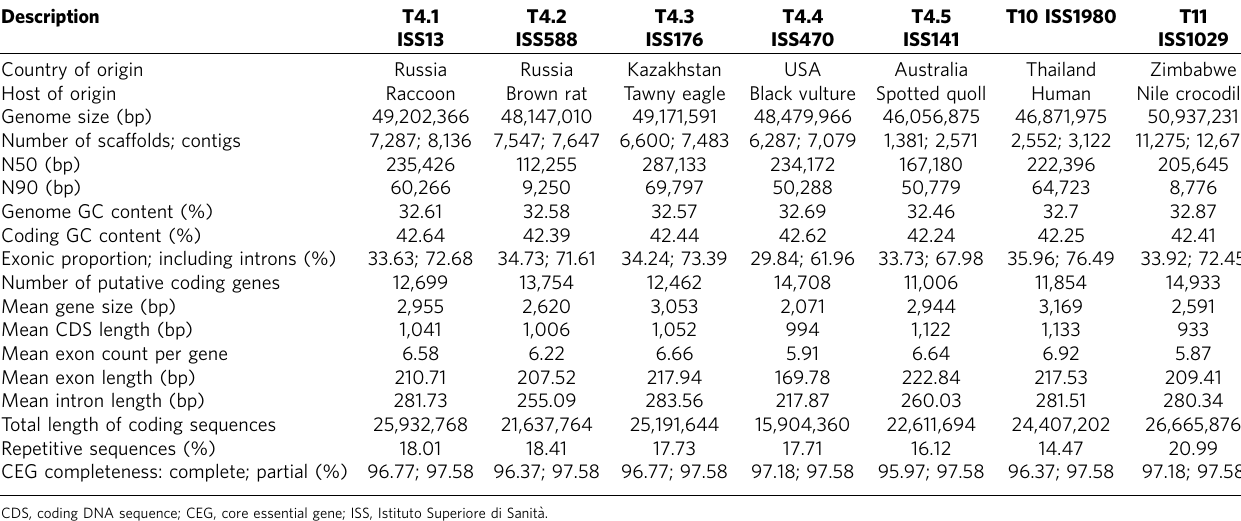
Table 2 | Assembly and gene prediction statistics for the draft genomes of all recognized non-encapsulated Trichinella taxa*.